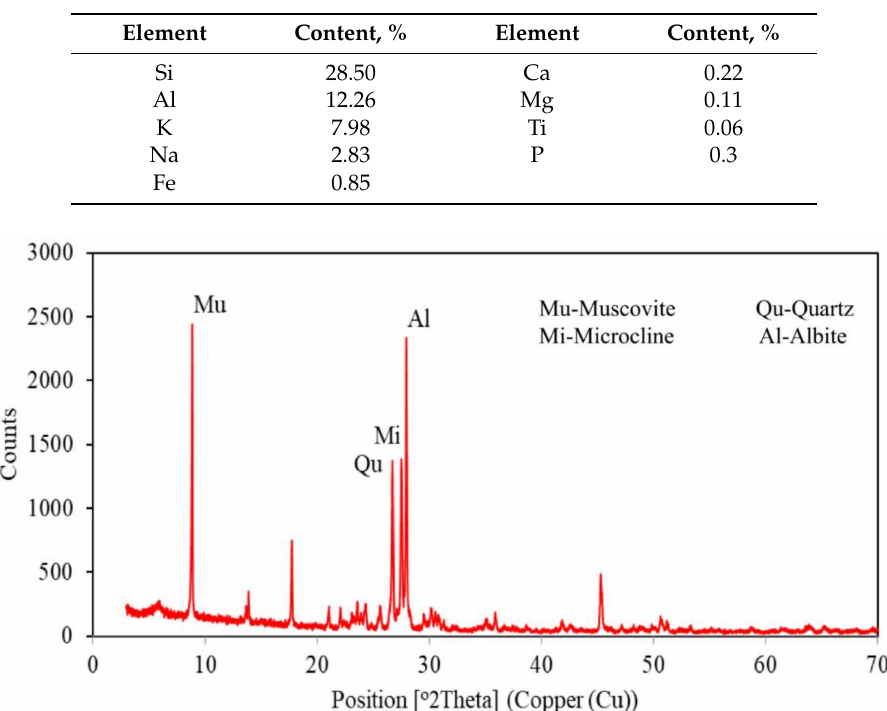
Figure 1. X-Ray Diffraction (XRD) patterns of the sample.